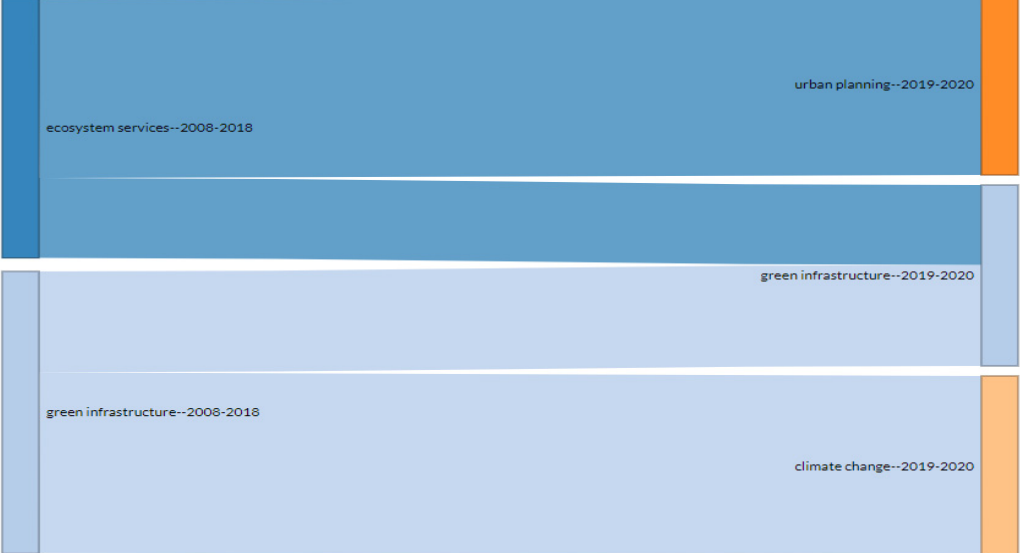
Figure 8. Topic Evolution by Author Keywords. Source: Biblioshiny. Own compilation.